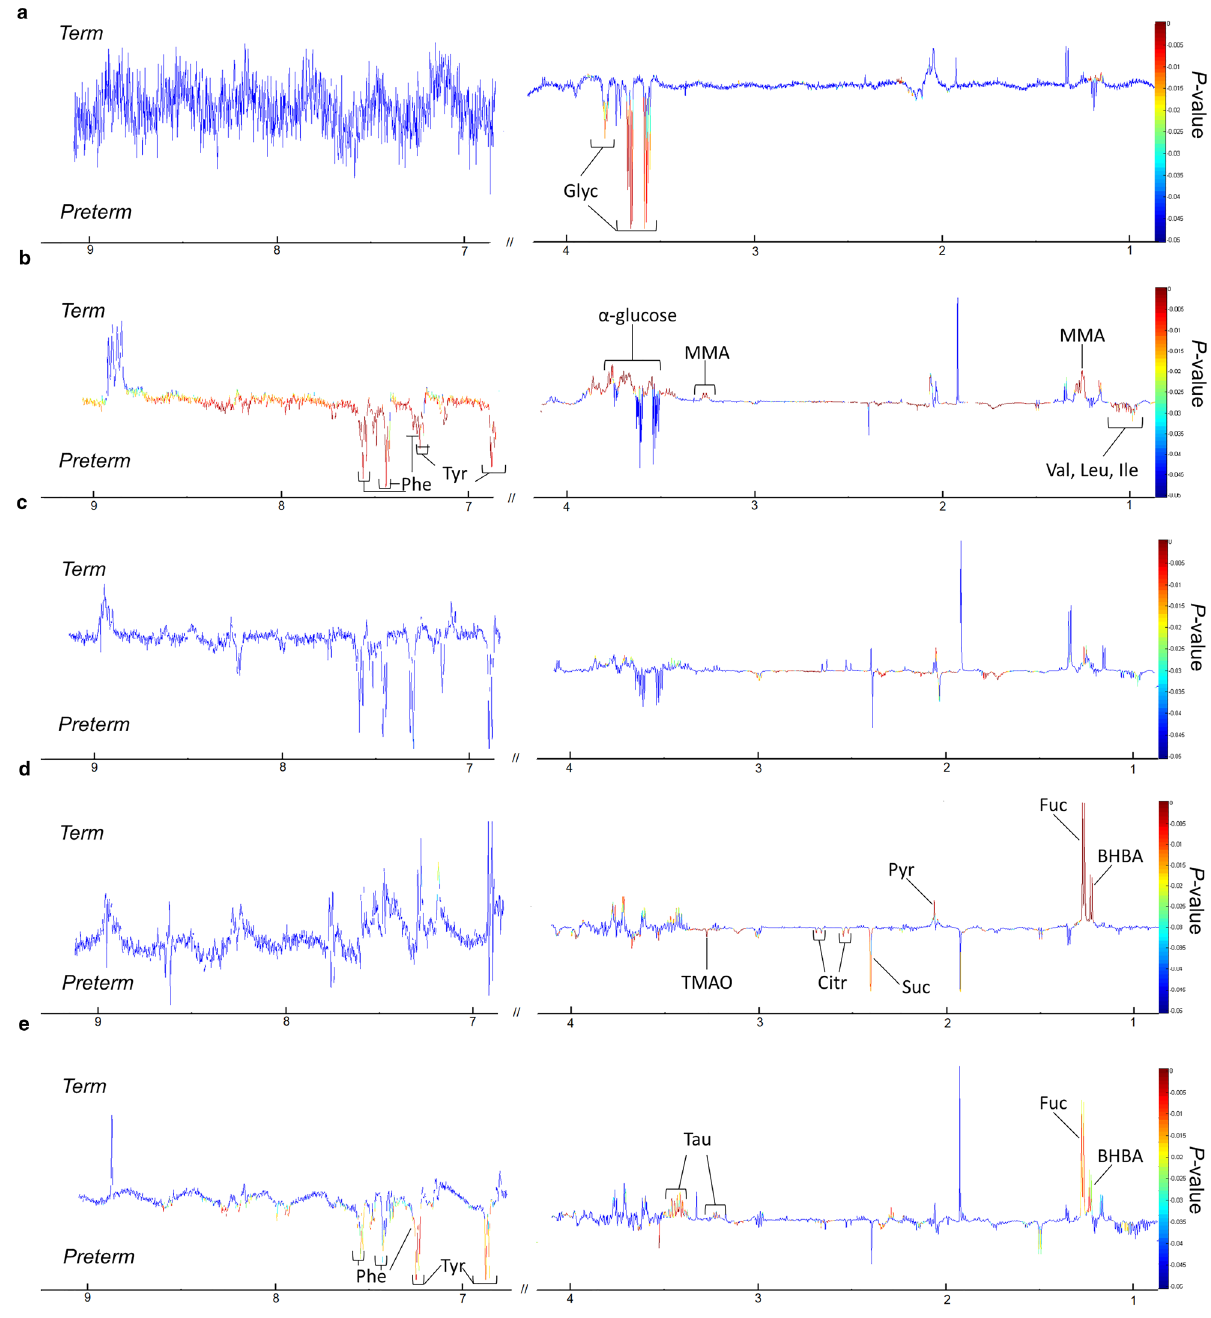
Figure 3. 1 H NMR spectroscopy showing the metabolite profiles of preterm and term controls. Covariance plots showing the colour-coded significance of stool metabolite profiles (red, P < 0.01) calculated using permutation test from ( a ) meconium, ( b ) week 1, ( c ) week 2, ( d ) month 6 and ( e ) month 12, were generated using MATLAB (version R2014a, https ://www.mathw orks.com) Key: BHBA, β-hydroxybutyrate; Citr, citrate; Fuc, fucose; Glyc, glycine; Ile, isoleucine; Leu, leucine; MMA, methylmalonic acid; Phe, phenylalanine;